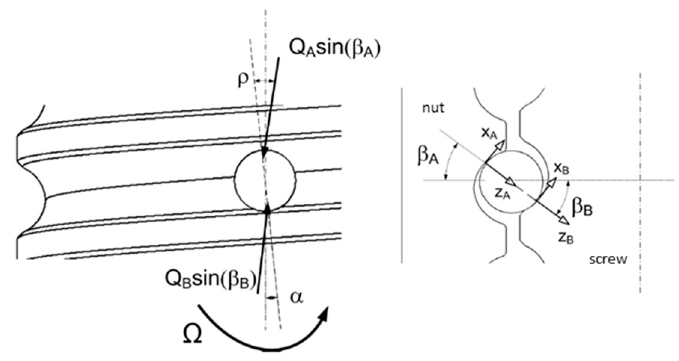
Figure 7. Equilibrium condition for a single rolling element within the ball-screw.